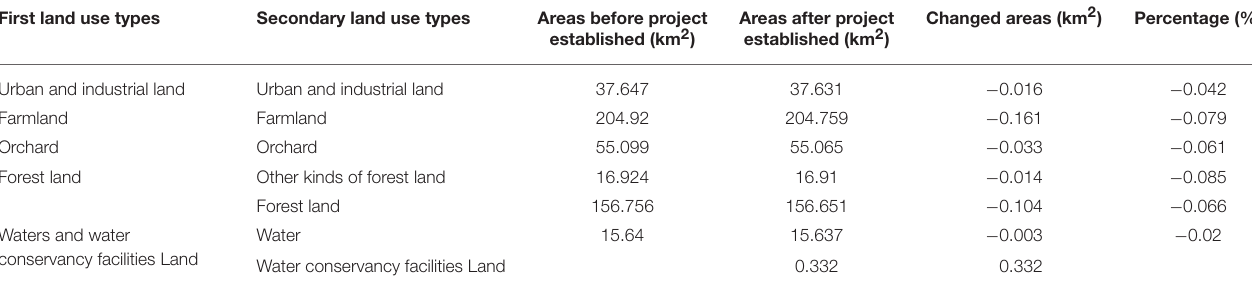
TABLE 1 | The land use area before and after Chaishitan water conservancy project